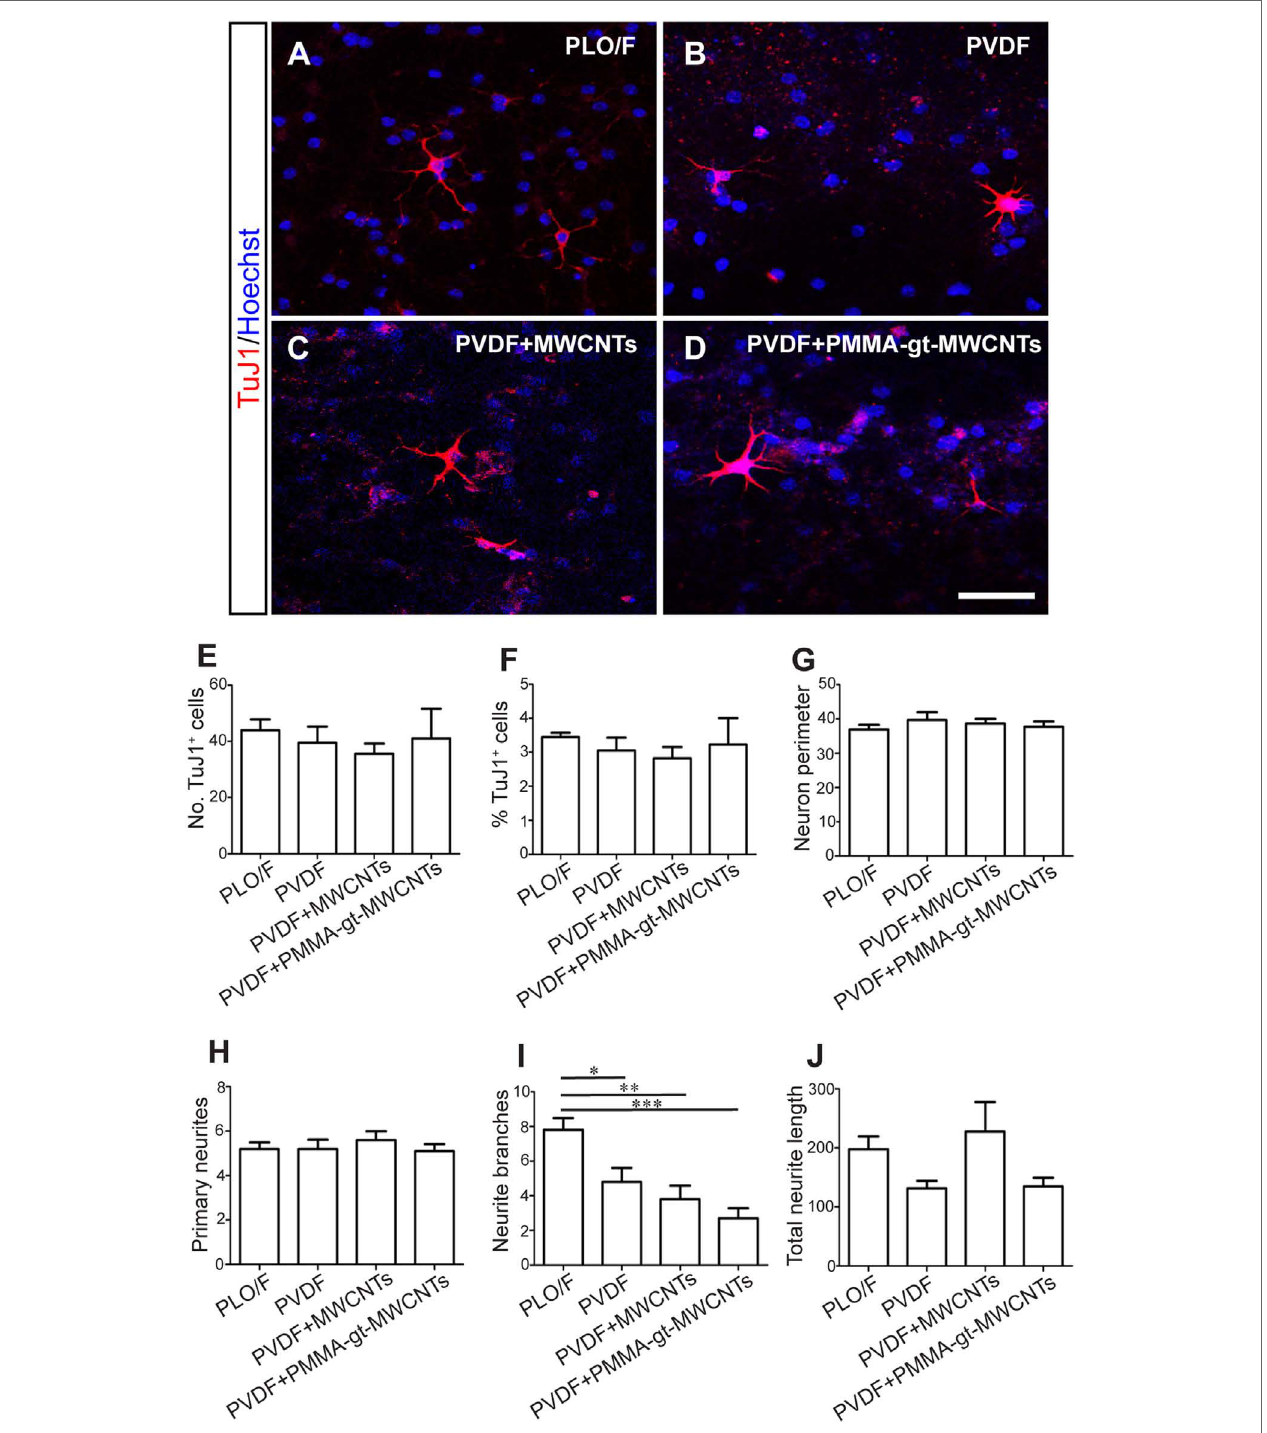
FigUre 8 | PVDF membranes are permissive substrates for neuronal survival but inhibit neurite branching . The aOBSC neurospheres were dissociated and seeded on PLO/F, and PVDF, PVDF + MWCNTs and PVDF + PMMA-gt-MWCNTs membranes in serum-containing medium for 7 days and formed neurons, which were detected by antibodies against β -III tubulin (TuJ1) (a–D) . Graphs show no significant differences in the numbers (e) and percentages (F) of TuJ1 + neurons grown on all conditions. There were no significant differences in the neuron perimeter, the primary neurites, and the total neurite length (g,h,J) . Compared to the PLO/F, neurons had significant decreases in neurite branches when grown on pristine and loaded PVDF membranes (i) . The graph bars represent the mean ± SEM ( n = 5–6 cultures per condition; n = 10 TuJ1 + neurons). Statistical analyses were performed using one-way ANOVA and Tukey’s test as post hoc analysis. * P < 0.05, ** P < 0.01, *** P < 0.001. Scale bar [shown in (D) ] = 31.5 μ